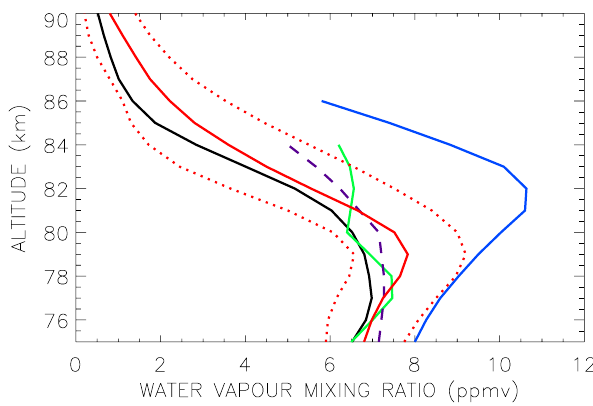
Fig. 6. A comparison between the constructed WINDII mean water vapour profile resulting from the 6 cases for July 1992 and 1993 (black solid line), the mean HALOE (v. 19) water vapour profile for August 1992 and 1993 (blue), the ACE water vapour profile at 66 ◦ N for July 2004 (green solid line), the HALOE, v. PMC wa- ter vapour profile, corrected for PMC contamination (dashed purple line) (McHugh, 2005), and the Odin/SMR mean water vapour pro- file in the presence of PMCs at 65 ◦ N–75 ◦ N, for July 2005 (red solid line). The standard deviation of the Odin/SMR profile in the presence of PMC is given with red dotted lines (adopted from Los- sow,